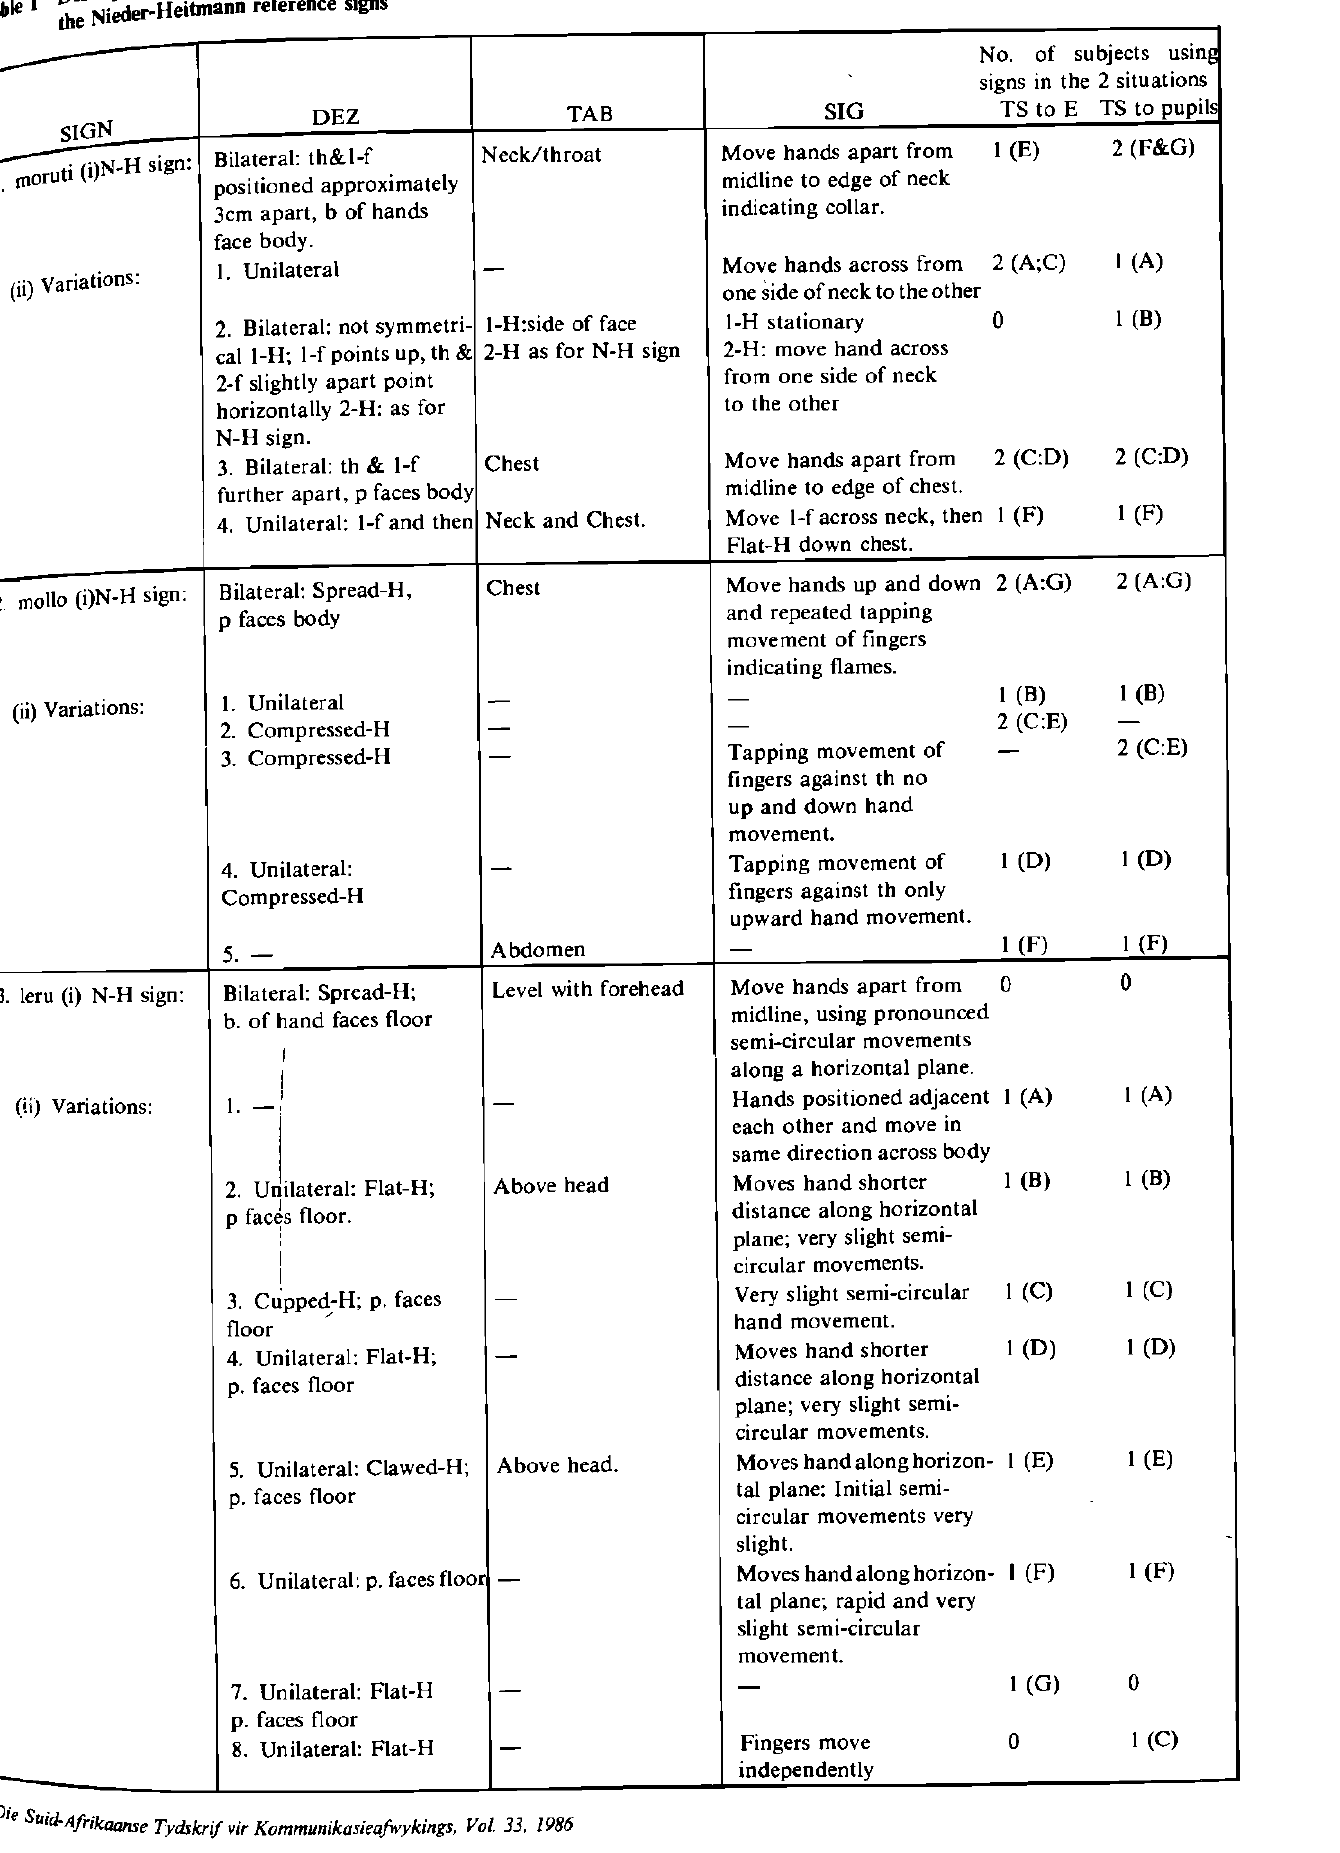
signs in the 2 situations TS to Ε TS to pupils